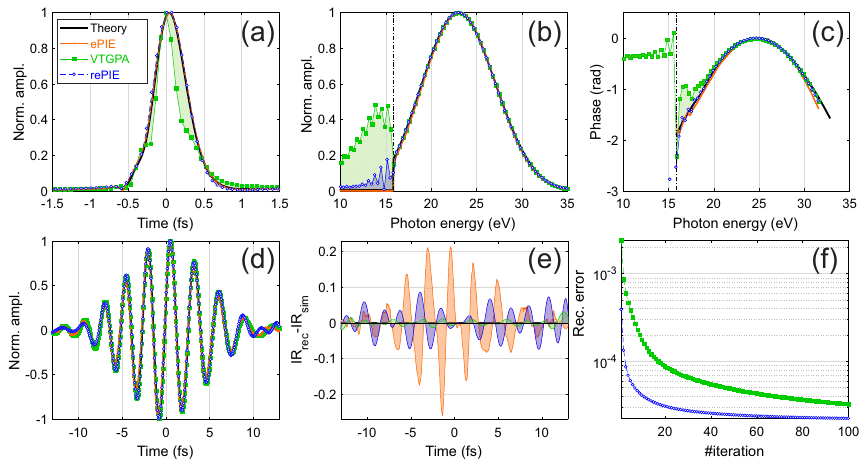
Figure 5. Attosecond pulses with spectrum centred around the 15th harmonic. ( a ) Temporal amplitude profile of the XUV pulse. ( b , c ) Associated spectra amplitude and phase. ( d ) Reconstructed IR femtosecond pulse. ( e ) Residual error between the simulated and reconstructed IR pulse. ( f ) Reconstruction error of the last 100 iterations for VTGPA and rePIE algorithms as a function of iteration number. In all the figures, orange full dots represent the ePIE results, green squared marks show the VTGPA results while the rePIE output is represented by the blue open